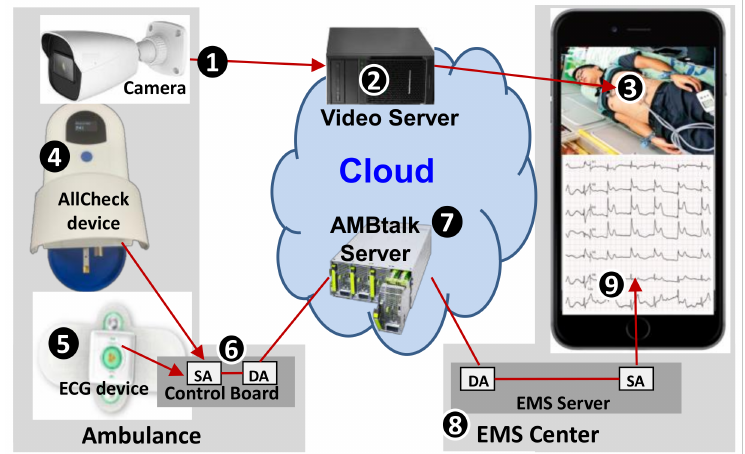
Figure 4. The cloud-based AMBtalk